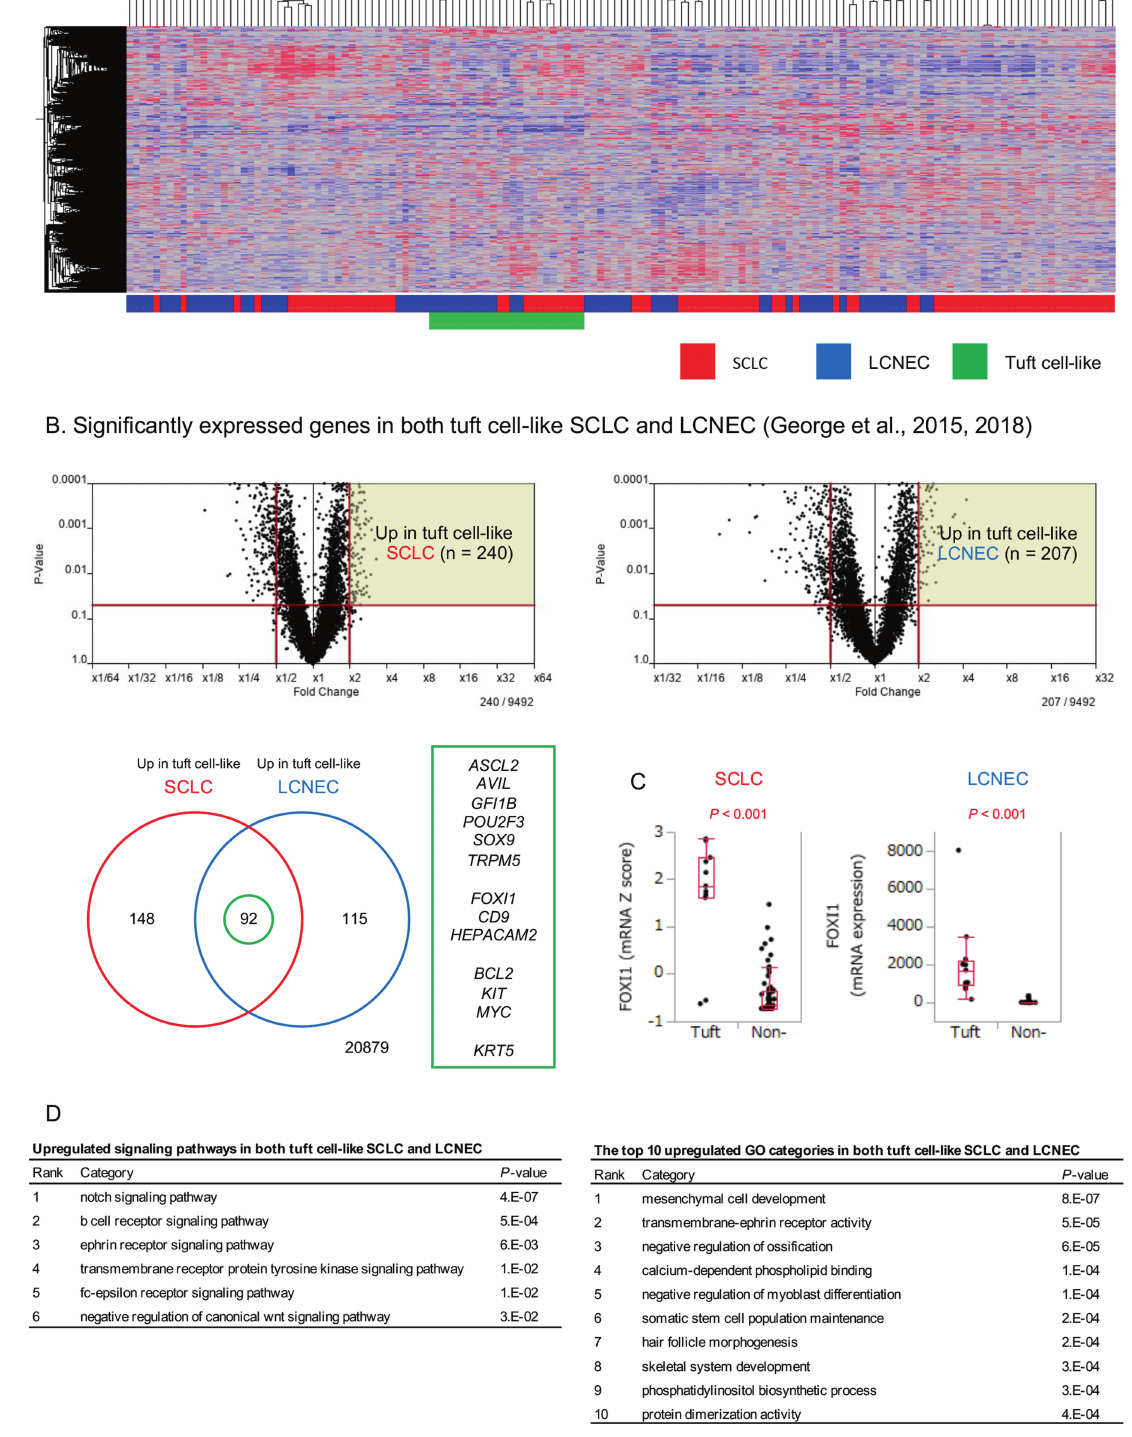
Fig. 4 mRNA expression of tuft cell-like small cell lung cancer (SCLC), pulmonary large cell neuroendocrine carcinoma (LCNEC), and squamous cell carcinoma (SQCC) ([24, 27], TCGA Nature 2012). A Unsupervised mRNA expression clustering with the combined SCLC and LCNEC cohort. B Signi fi cantly expressed genes in both tuft cell-like SCLC and LCNEC, compared with the respective non-tuft cell-like counterparts (>2 folds, P < 0.05). POU2F3 , GFI1B , TRPM5 , SOX9 , ASCL2 , AVIL , representative tuft cell genes; FOXI1 , the master regulator of ionocytes; BCL2 , KIT , and MYC , well-known oncogenes; KRT5 , a marker of squamous differentiation, were included among the 92 genes. C FOXI1 mRNA expression in tuft cell-like SCLC and LCNEC. The numbers of the y -axis indicate mRNA expression Z score in SCLC and FPKM (fragments per kilobase of exon per million reads mapped) in LCNEC. D The pathways and gene ontology (GO) analyses for upregulated genes in tuft cell- like SCLC and LCNEC. Genes related to the Notch signaling pathway were most signi fi cantly enriched. Cell Death and Disease (2022)